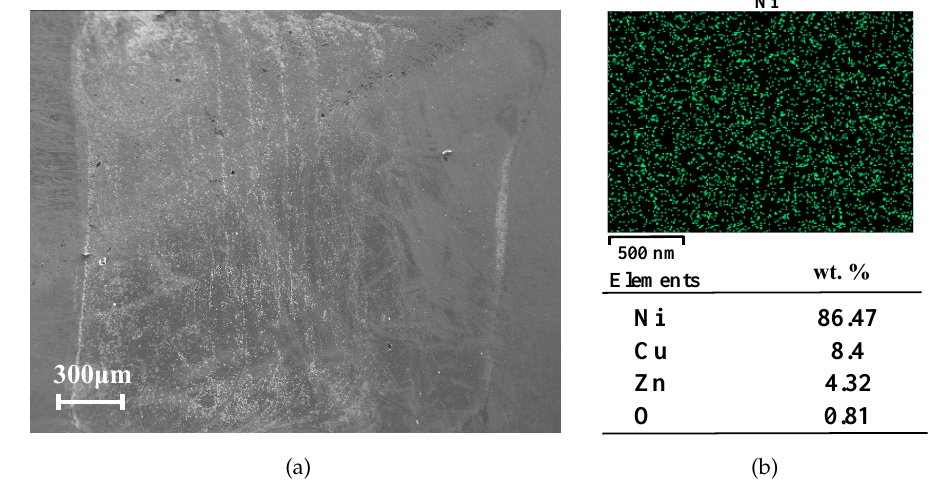
Figure 12. ( a ) The printed nickel square. ( b ) EDX element mapping for a small region of the printed nickel square and the corresponding wt.% of the detected